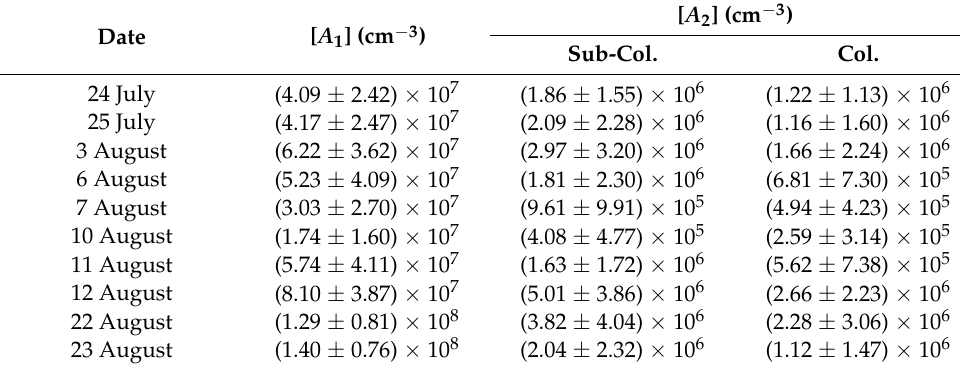
Figure 1. Temporal profiles of lognormal function fit for m/z 166 ( a ), and BGCs for m/z 160 ( b ) and m/z 195 ( c ), during the event on 22 August. See the main texts for details. Table 1. The average concentrations of sulfuric acid monomers and dimers with sub-collision rate corrections for all the events in this